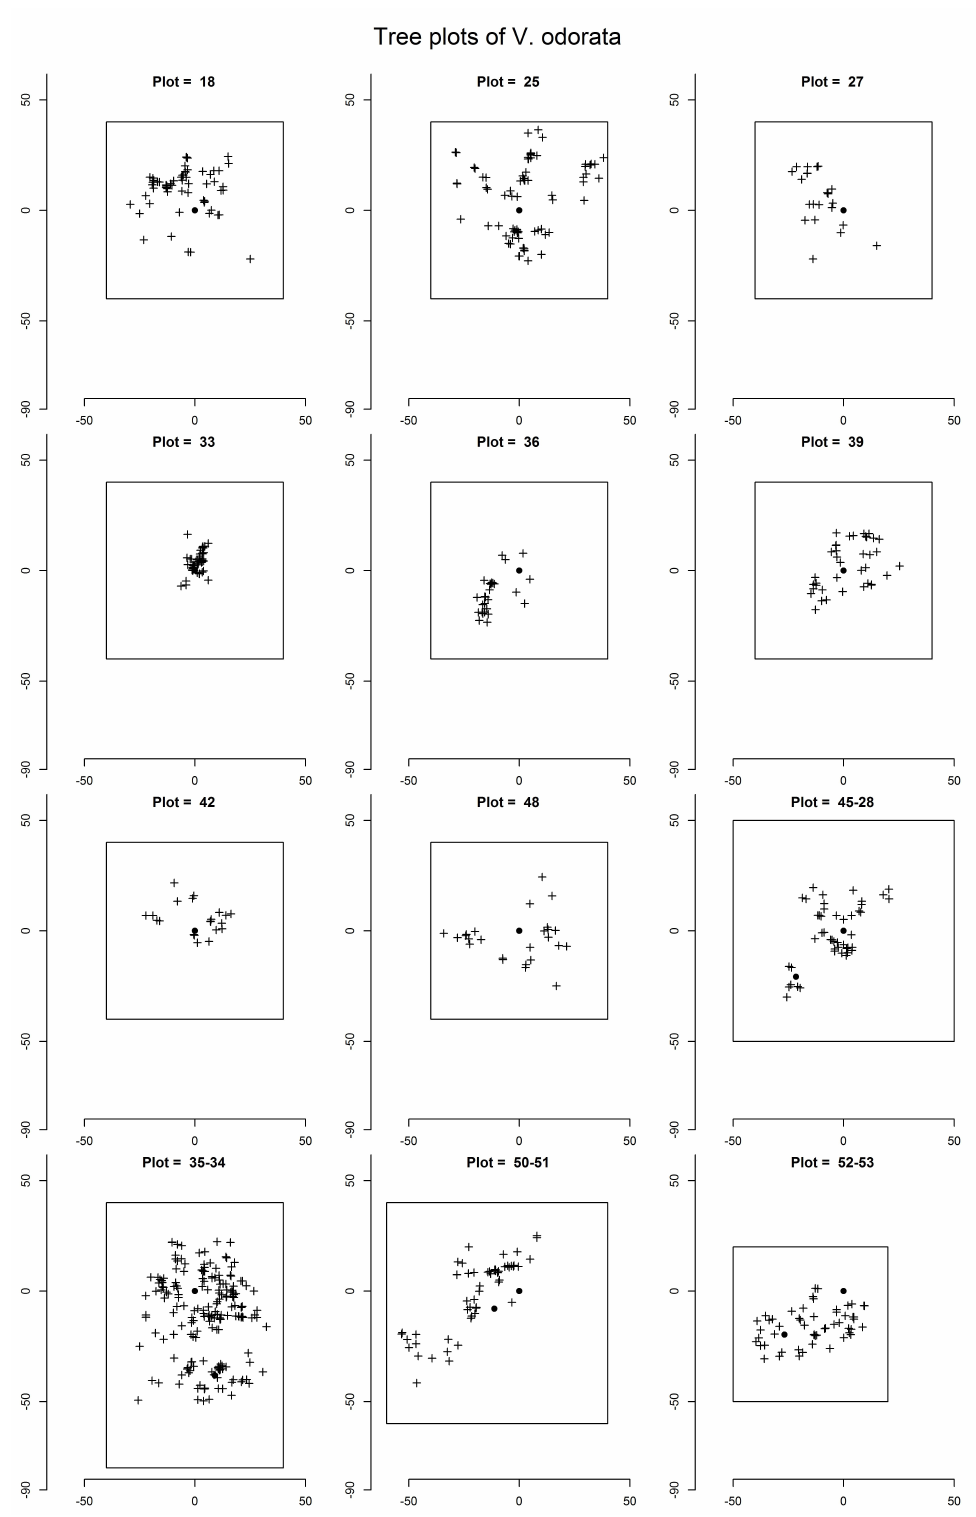
’ whereas seedlings are indexed •